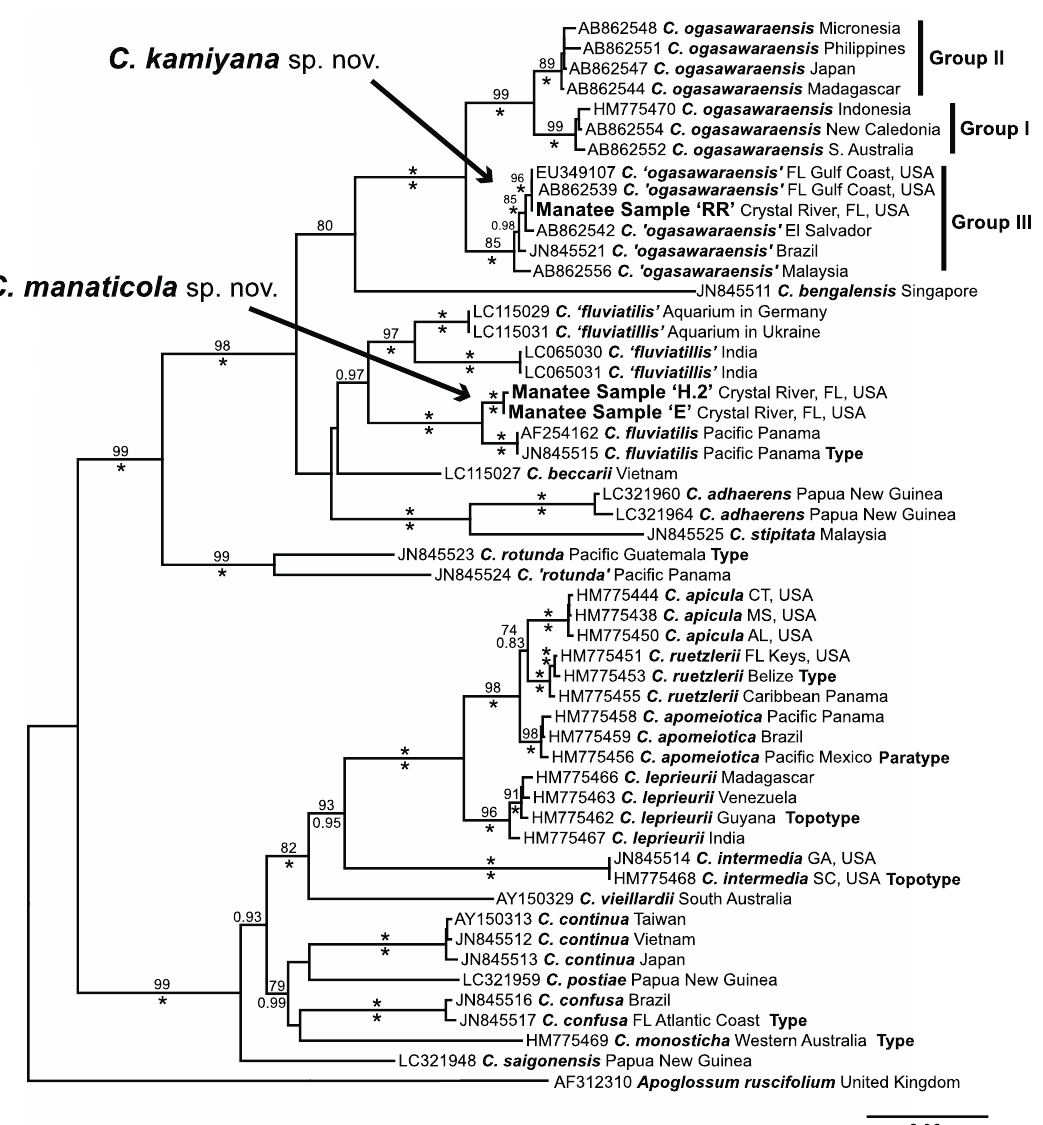
Figure 1. Maximum likelihood tree resulting from analysis of 52 Caloglossa specimen rbc L sequences and outgroup Apoglossum ruscifolium . Maximum likelihood bootstrap support and Bayesian posterior probabilities are shown for branches when >70% and >0.80, respectively; * , full support. Type, sequence from type collection or culture of type collection.